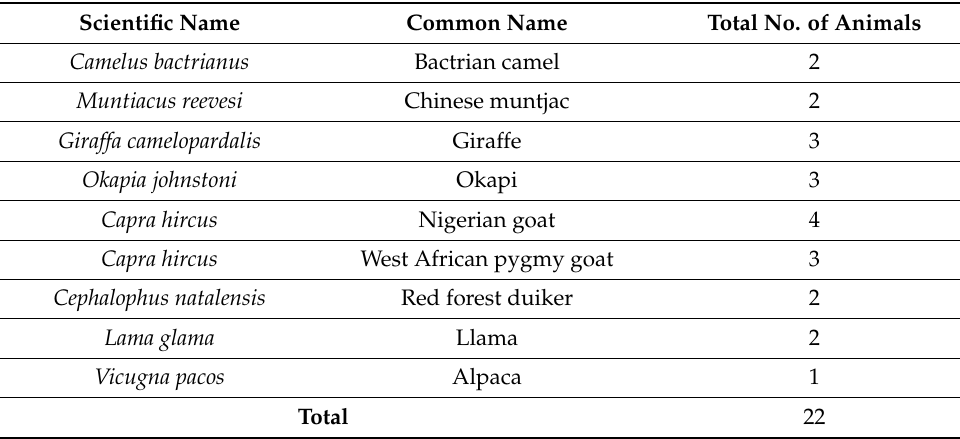
Table 2. ZSL London Zoo animals at risk of BTV infection in 2019